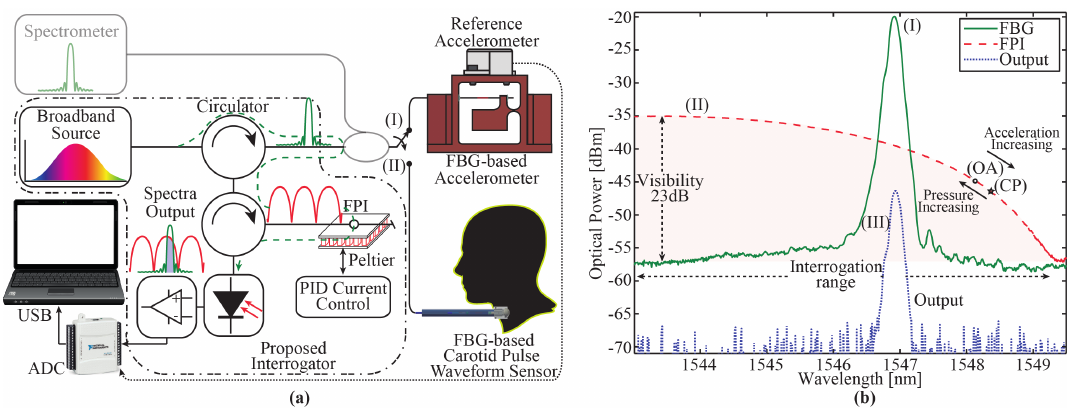
Figure 1. ( a ) Setup of the proposed interrogator; ( b ) Spectra of the proposed interrogation system, acquired by an optical spectrum analyzer (OSA). (I), (II) and (III) represent the spectra of fiber Bragg grating (FBG), Fabry–Perot interferometer (FPI), and output, respectively. (OA) and (CP) are the central wavelength of the optical accelerometer and carotid pulse waveform sensor,